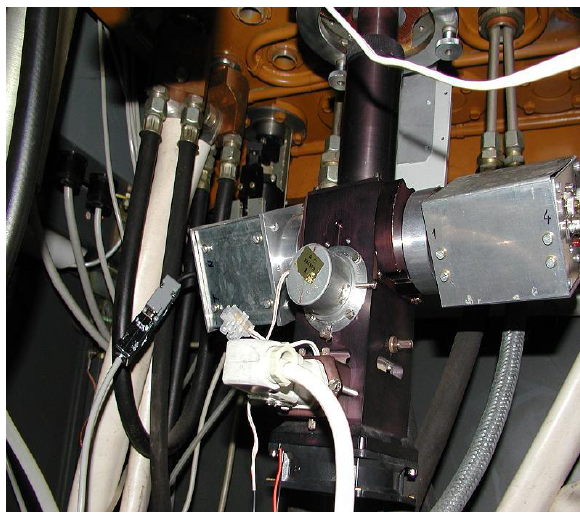
Fig. 5. Prototype of the test version of